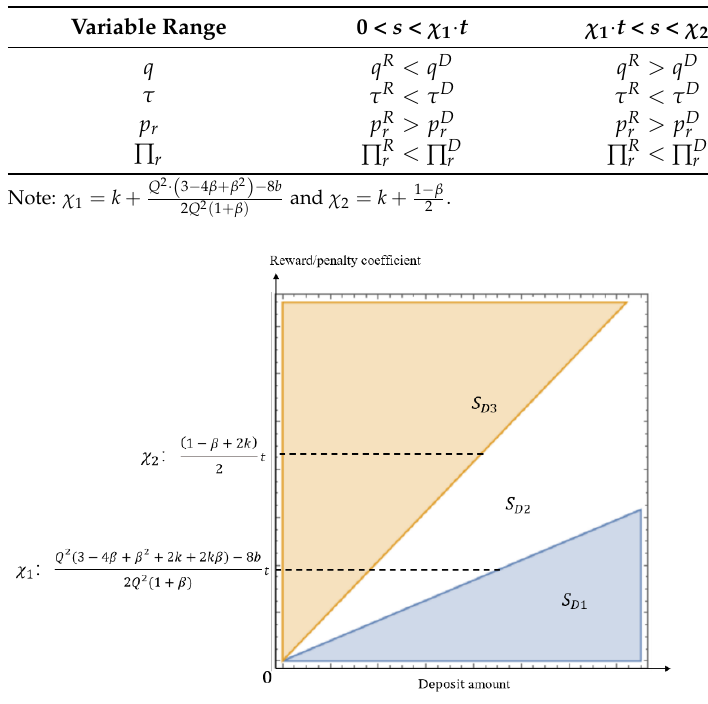
Figure 2. Impact of the reward/penalty coefficient and deposit amount.